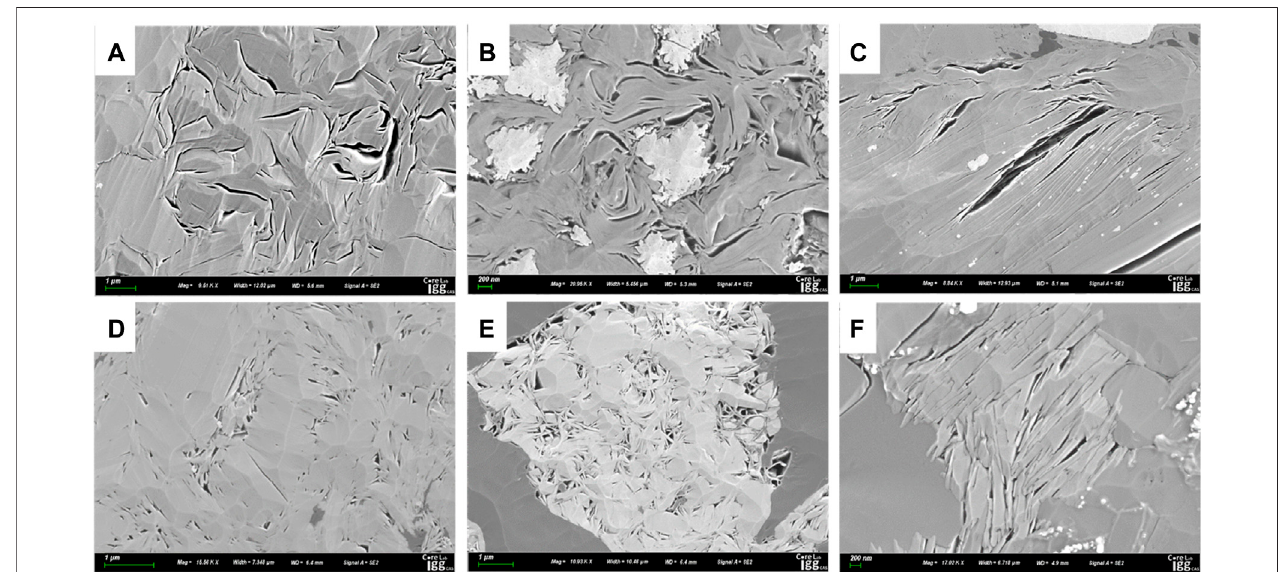
FIGURE 6 | Pores developed in clay minerals [ (A) 59.6% of clay minerals; intracrystalline pores in clay minerals, slender and curved in shape, and 200 nm to 2 μ m length; (B) 61.1% of clay minerals; clay minerals are associated with pyrite. Interlayer fractures of clay minerals are well developed and the width of fractures is generally less than 100 nm; (C) 33.0% of clay minerals; intragranular pores of clay minerals, elongated in shape, 50 – 600 nm width, and 1 – 6 μ m length; (D,E) 43.8% of clay minerals; interlayer pores of clay minerals, pore size ranges from 20 – 100 nm; (F) 37.7% of clay minerals; intragranular pores of clay minerals, triangular or parallel plates, 100 nm width, and 100 – 800 nm length).